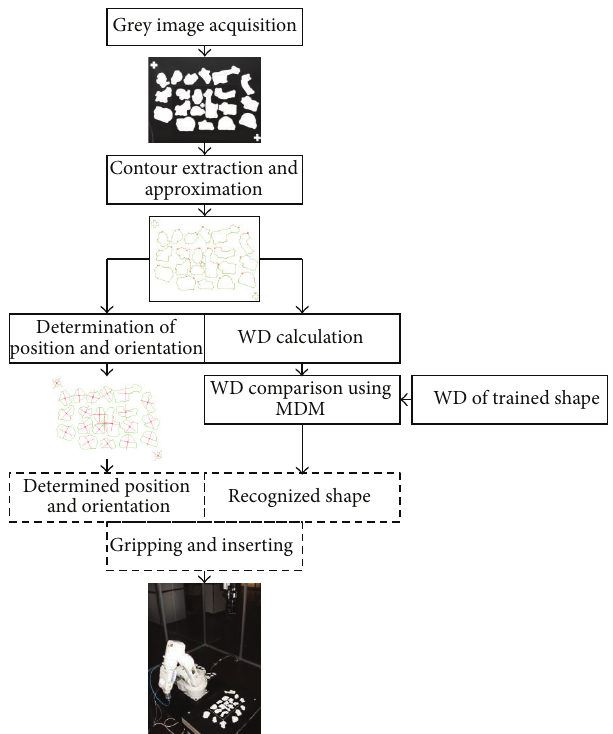
Figure 8: Overall procedure of the shape description and recogni-